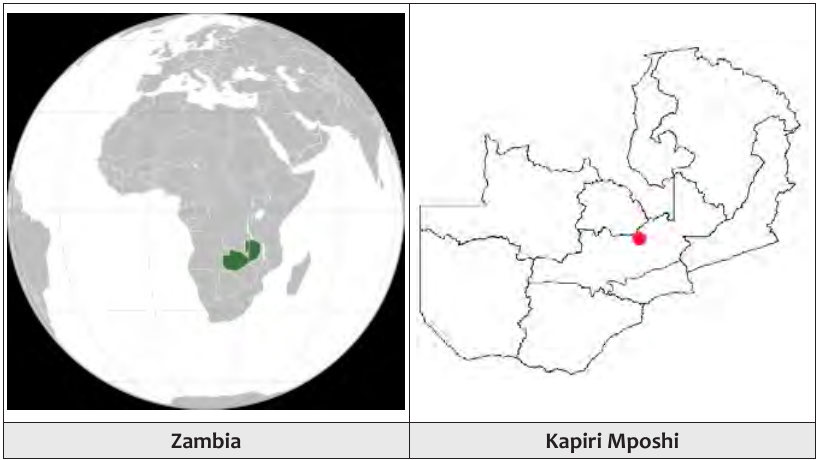
Figure 1: Study Location: Zambia and Kapiri